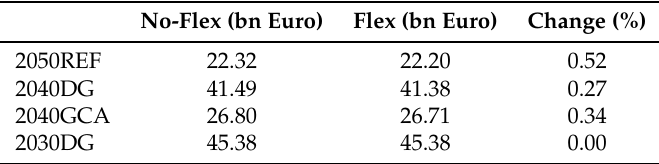
Table 3. Objective value for scenarios with (Flex) and without (No-Flex) flexibilisation. Deviation may occur due to rounding of values inside the